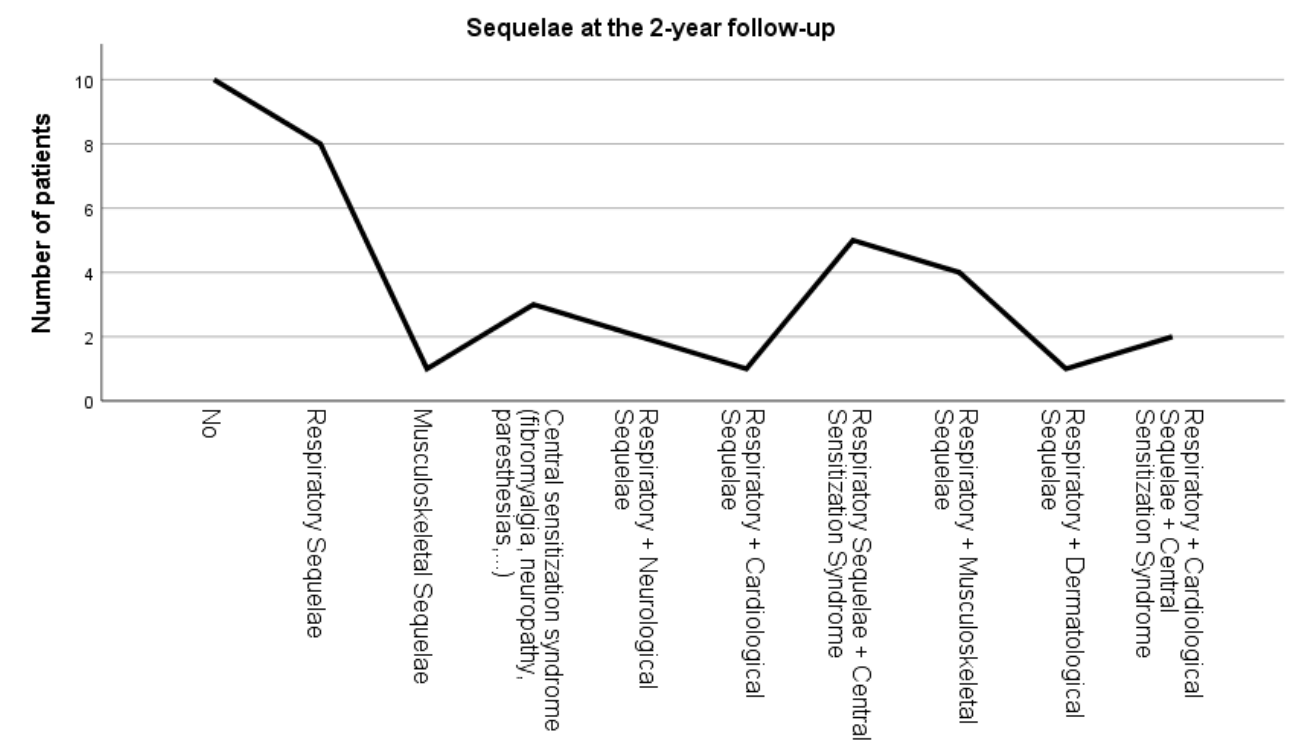
Figure 5. Signs and symptoms occurring at the 2-year follow-up period.